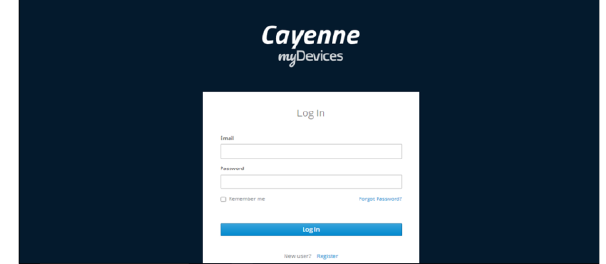
Figure 9. The Main Page for Authorized Users.